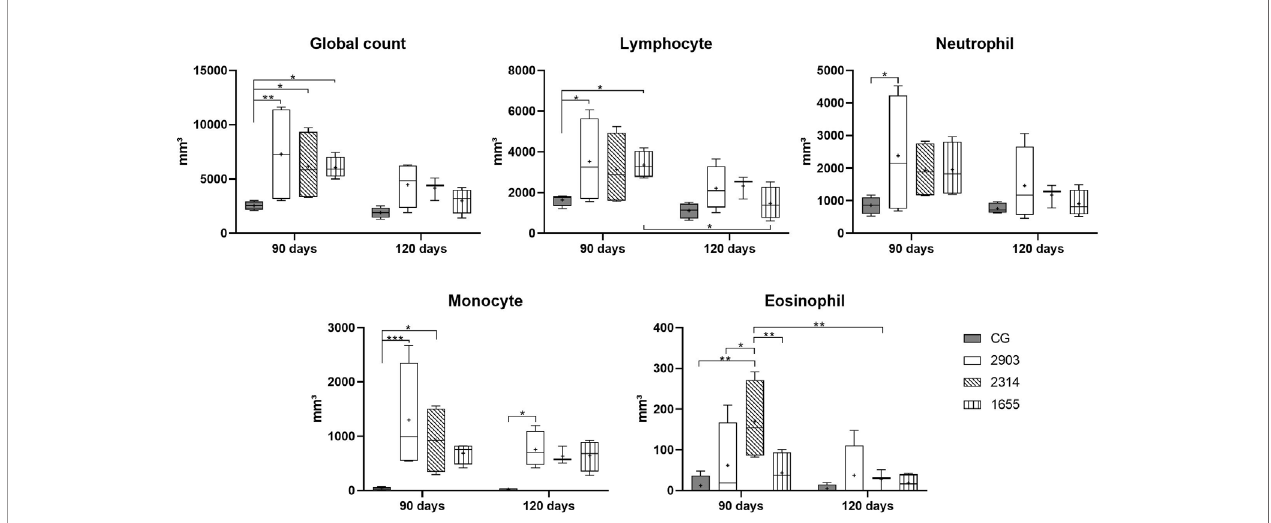
FIGURE 3 | Global and differential leucocyte counts in peripheral blood in hamsters infected with three strains of L. (V.) braziliensis for 90 and 120 days. Data is represented in box plots (median with 25 to 75 percentile), whiskers (2.5 to 97.5 percentile), and mean (+) ( n = 4). * p < 0.05; ** p < 0.01; *** p < 0.001. CG, control group. 2903: group infected with MHOM/BR/1975/M2903. 2314: group infected with MHOM/BR/2003/2314. 1655: group infected with MHOM/BR/2000/1655.